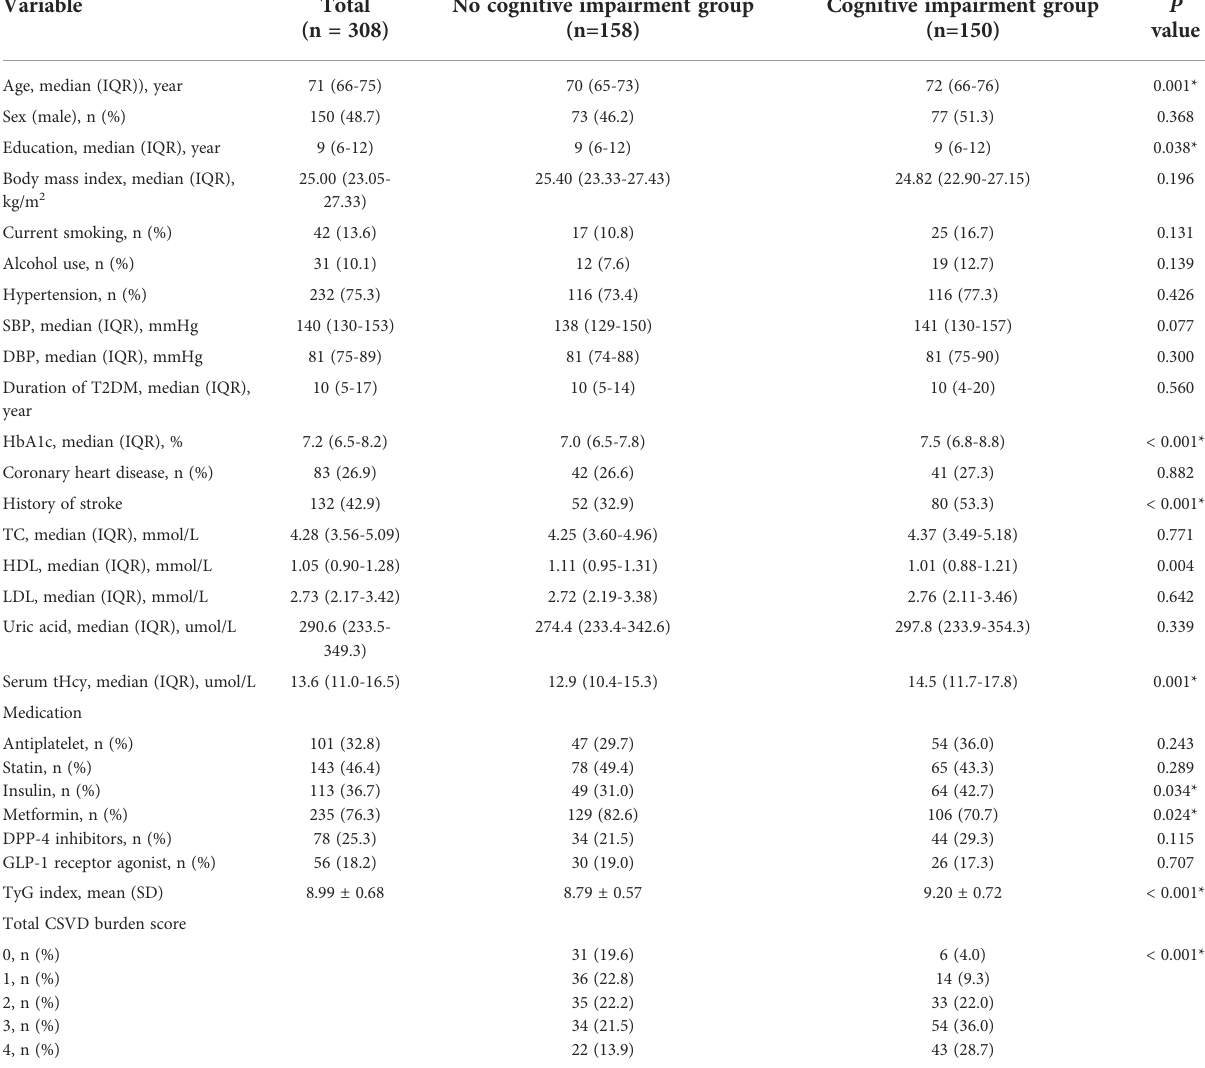
TABLE 1 Characteristics of the study participants between no cognitive impairment and cognitive impairment group. Variable Total No cognitive impairment group (n = 308)